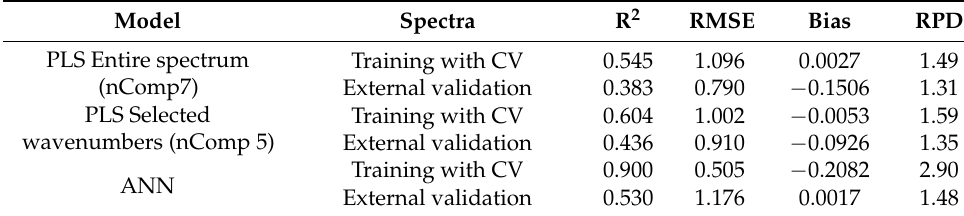
Table 4. Best performing models’ parameters for BCh.